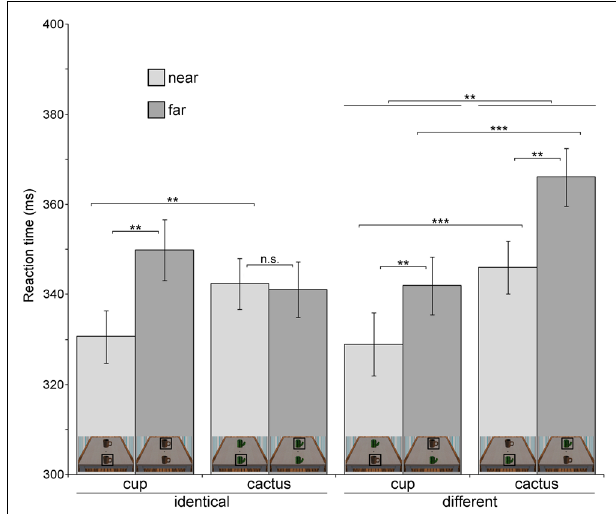
FIGURE 2 | Reaction times in the probe detection task for each of the eight experimental conditions (Experiment 1). For clarity, miniature pictures of the stimulus corresponding to each condition are shown at the bottom of each bar.The object at which the luminance probe appeared in a specific condition is marked with a black square. Error bars denote ± 1 SEM. Significance levels are indicated for effects of interest. ** p < 0.01, *** p < 0.001, n.s.-not